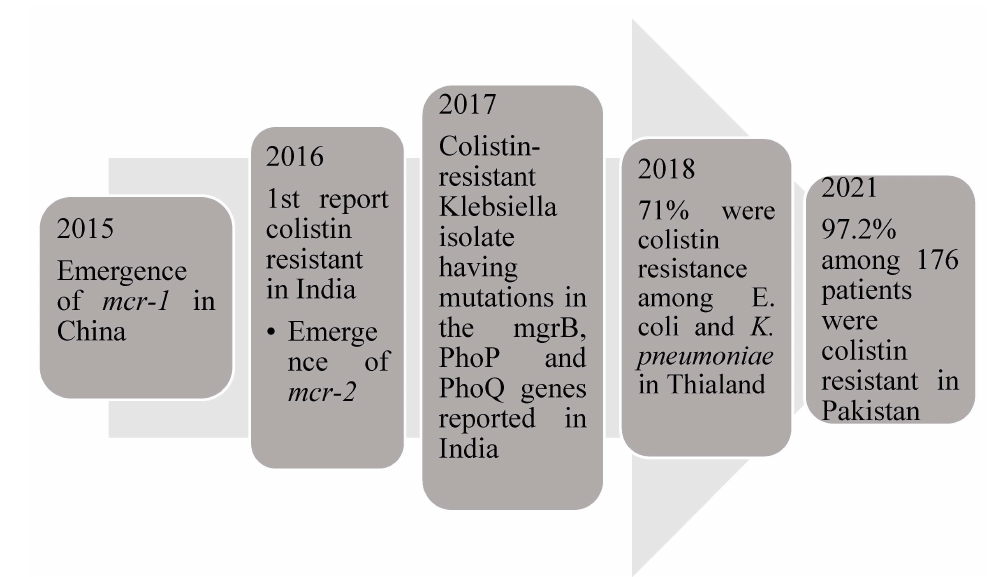
Figure 2. Emergence of colistin resistant gene and the cases associated with them. Table 1. Comparison of MIC values [mg/L] of various antibiotics with Chloramphenicol. Organisms Klebsiella pneumonia Escherichia coli Staphylococcus aureus